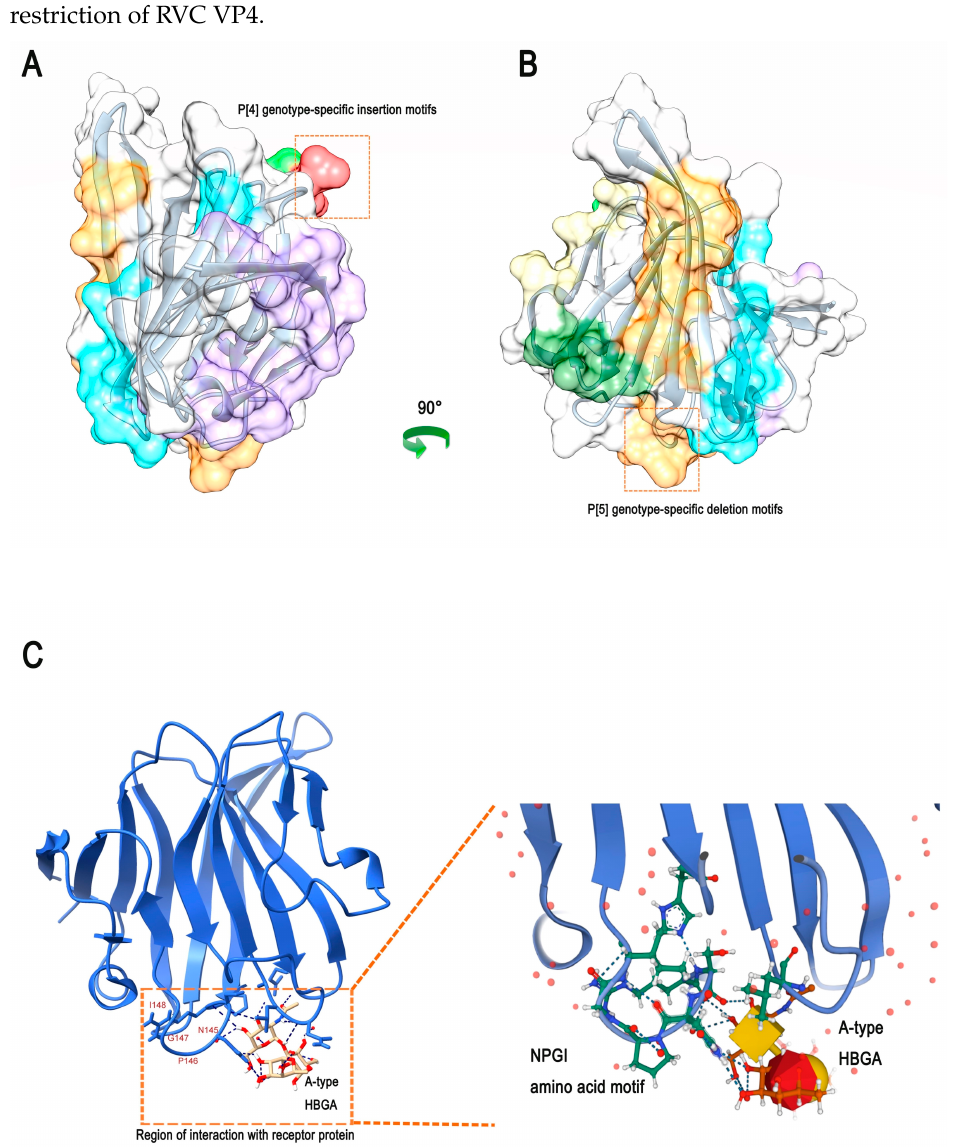
Figure 5. Prediction of human RVC VP8* B-cell epitopes and the recognition of host cell glycan complexes. ( A ) Shows a 90 ◦ -flip of the image in ( B ). A total of seven epitopes were predicted, the first of which was ‘I-E-W-S-N-L-I’, as highlighted in purple. The second was ‘L-N’, as highlighted in red. The third was ‘G-K-S-G-T-T’, as highlighted in light green. The fourth was ‘Q-N-K-T-H-D-A-N-S’, as highlighted in gold. The fifth was ‘E-G-S-T-Q-L’, as highlighted in dark green. The sixth was ‘V-G-G-I-L-I-K-P-I-N-S-S’, as highlighted in blue. The seventh was ‘N-W-N-H-E-F-P-R-S-N-P-G-I-N’, as highlighted in orange. The position of the P [4]/P [5] genotype-specific insertion or deletion motif of swine RVC is indicated by red boxes. ( C ) Human RVC recognition of the host cell glycan complex VP8* protein 3D structure (PDB: 5ZHO).